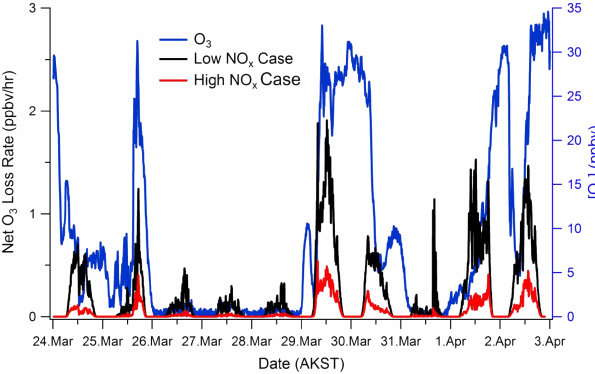
Figure 5. Calculated net O 3 loss rate for the low NO x and high NO x simulations, along with the observed O 3 mixing ratios.